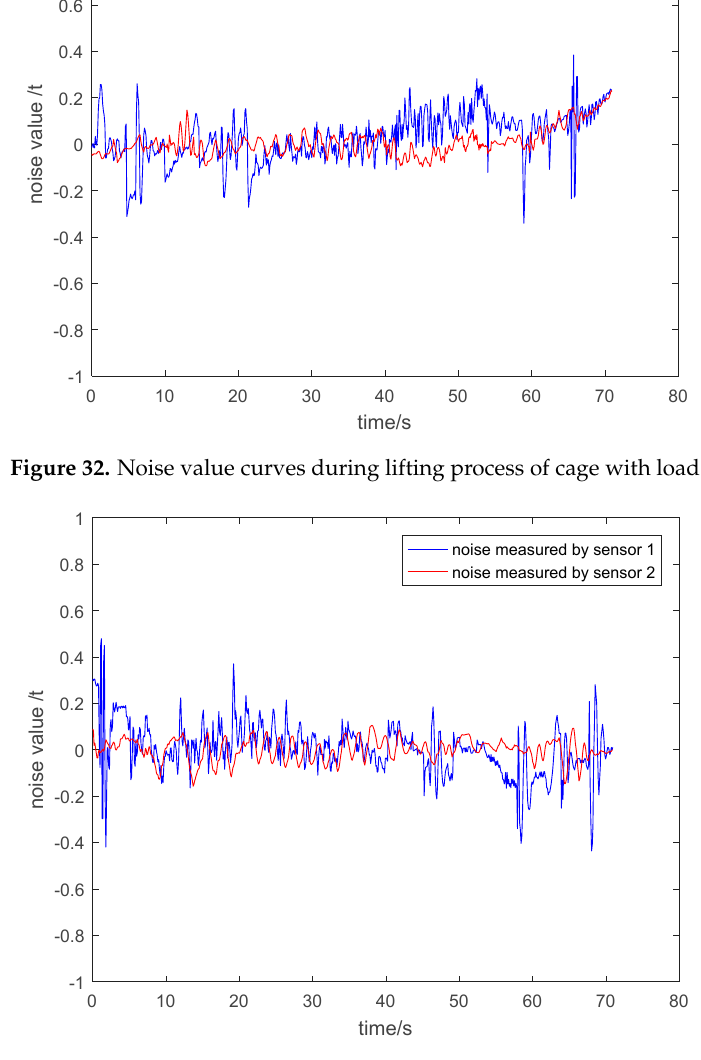
Figure 33. Noise value curves during descending process of cage with load.